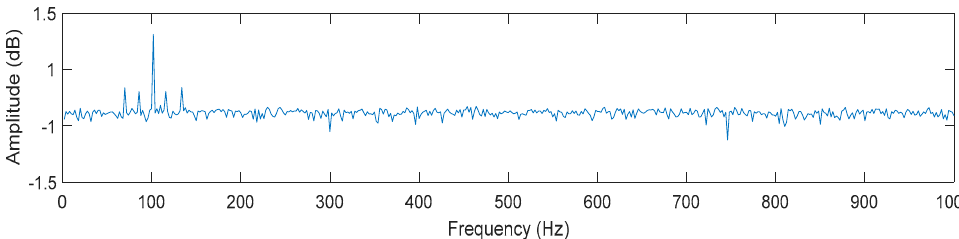
Figure 9. Signal after Butterworth filtering.